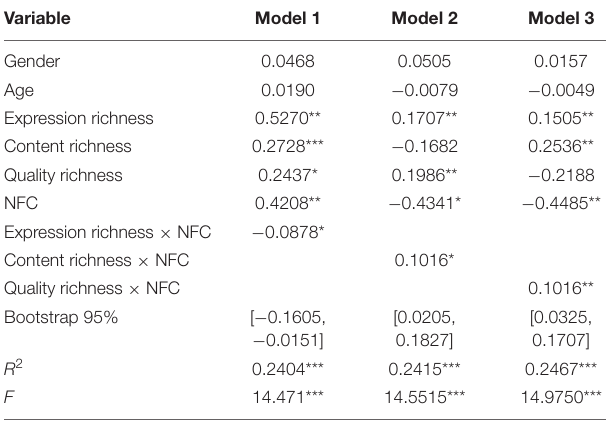
TABLE 6 | The analysis results of the moderator